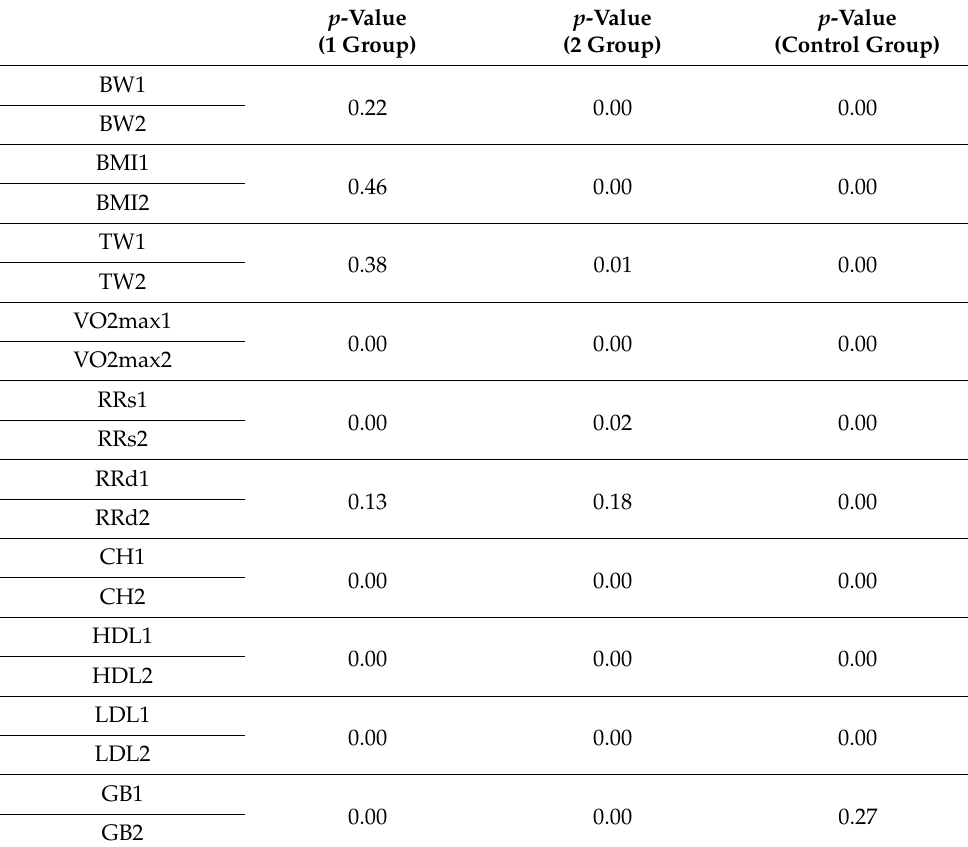
Legend : BW1—body weight 1. measurement, BW2—body weight 2. measurement, BMI1—body mass index 1. measurement, BMI2—body mass index 2. measurement, TW1—total amount of water 1.